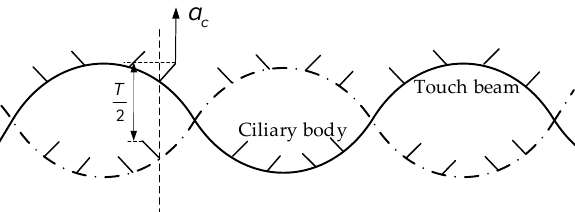
Figure 10. Schematic diagram of the acceleration of the ciliary-like body.